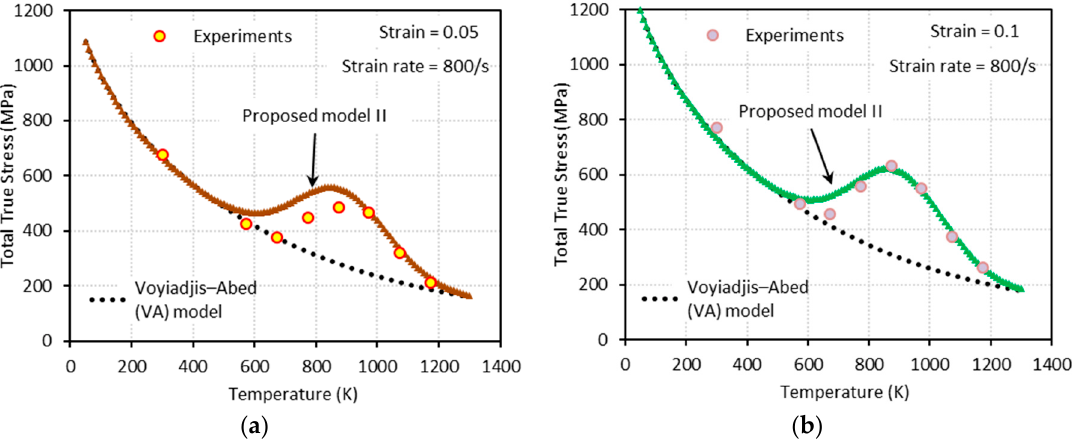
Figure 16. Comparisons between model predictions from the VA and proposed model II and experimental data from [1] on the total true stress versus temperature responses at ( a ) 𝜀 = 0.05 and ( b ) 𝜀 = 0.1 . Dynamic loading with 𝜀̇ = 800 𝑠 −1 is applied.